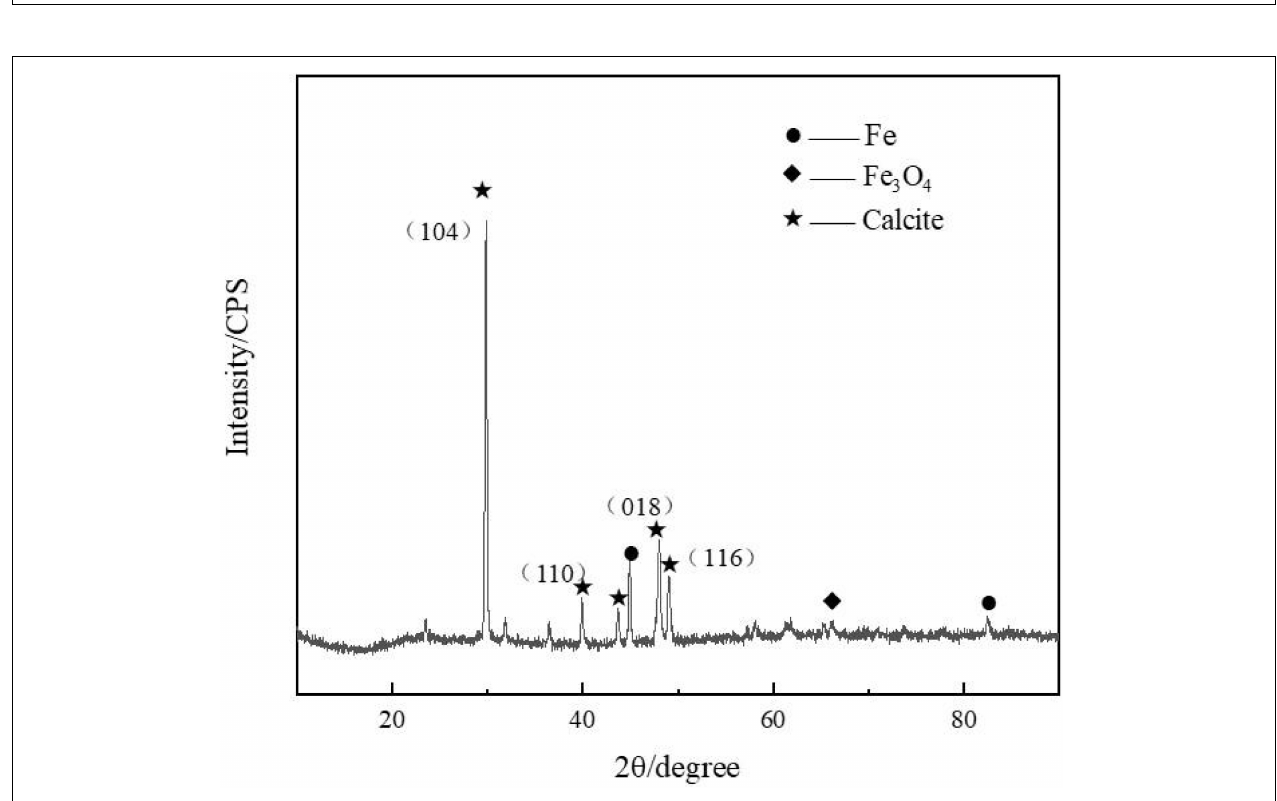
FIGURE 3 | Presence of calcite (mainly calcium carbonate) was confirmed by the X-ray diffraction (XRD) spectrum measured on the steel specimens after 3 days of immersion in marine broth with Bacillus subtilis strain.